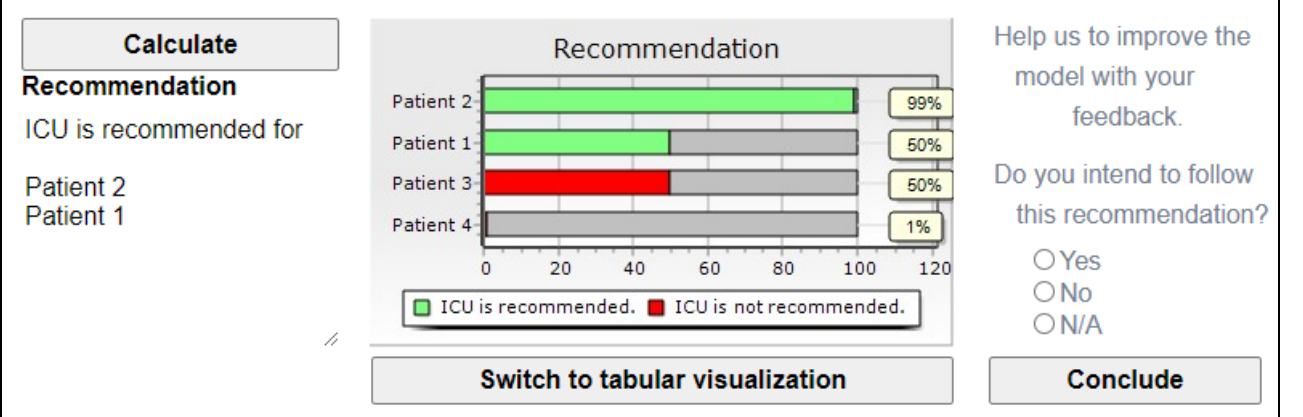
Figure 4. Results and recommendation (graphical visualization).